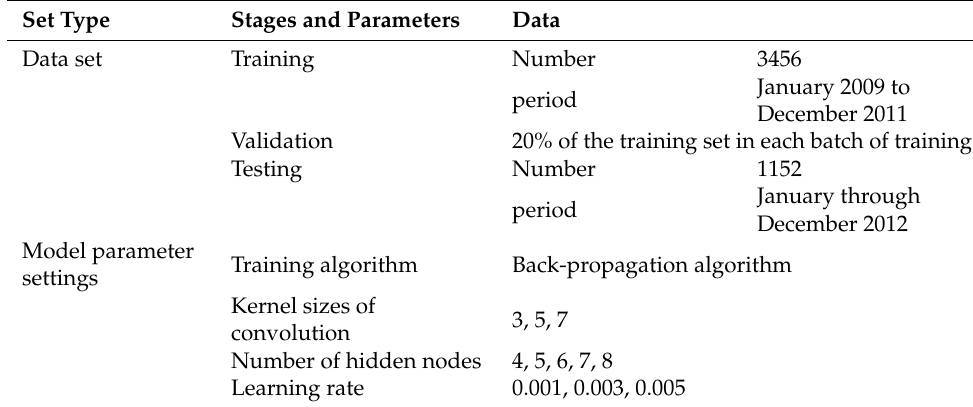
Table 2. Description of the data set and network set for ANN models.